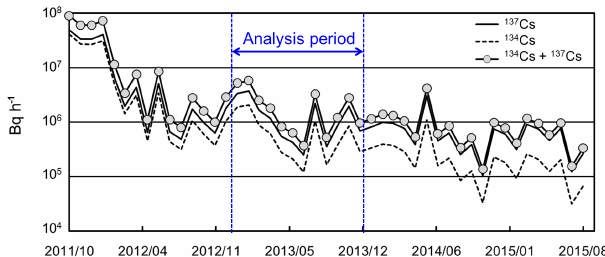
Figure 3. Monthly mean emission flux of radiocesium released from the reactor buildings of FDNPP from October 2011 to August 2015 as estimated by TEPCO (TEPCO,